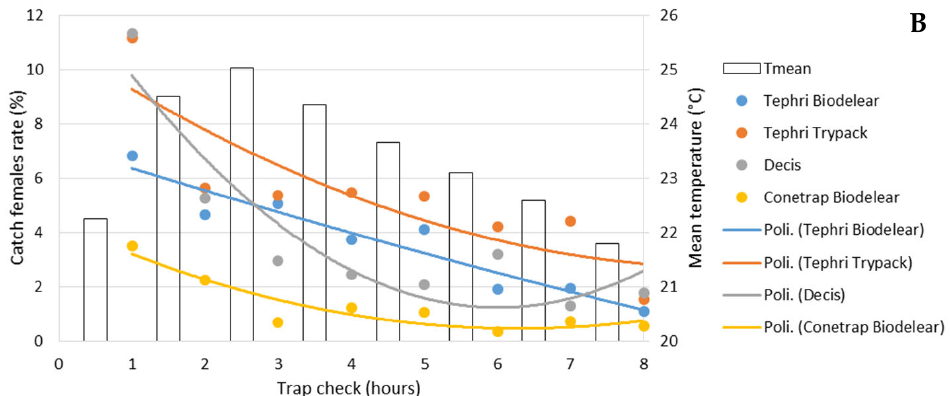
Figure 5. Performance of male ( A ) and female ( B ) catches (as %) in the 8 checks in the four trapping devices and mean temperature recorded.